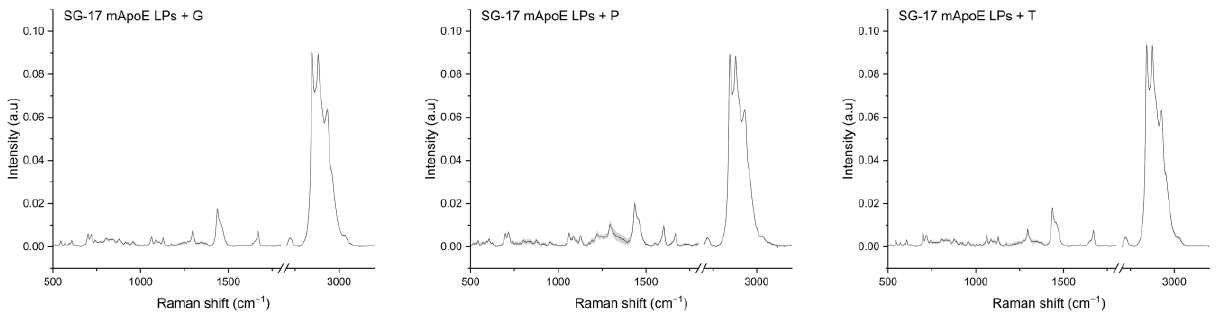
Figure 2. Raman spectra of the SG-17 mApoE LP + glibenclamide/G, SG-17 mApoE LP + pi- masertib/P and SG-17 mApoE LP + trametinib/T formulations. Spectra are presented as the average (dark line) after baseline subtraction; grey areas represent the standard deviation.